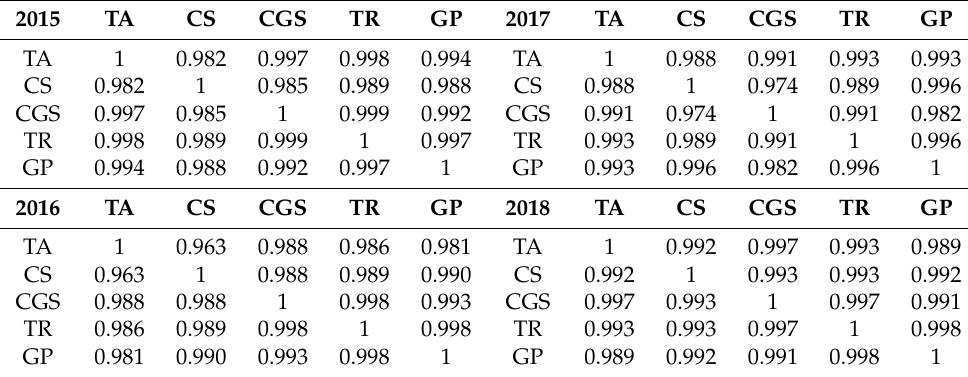
Table A9. Pearson correlation coefficient (2015–2018).